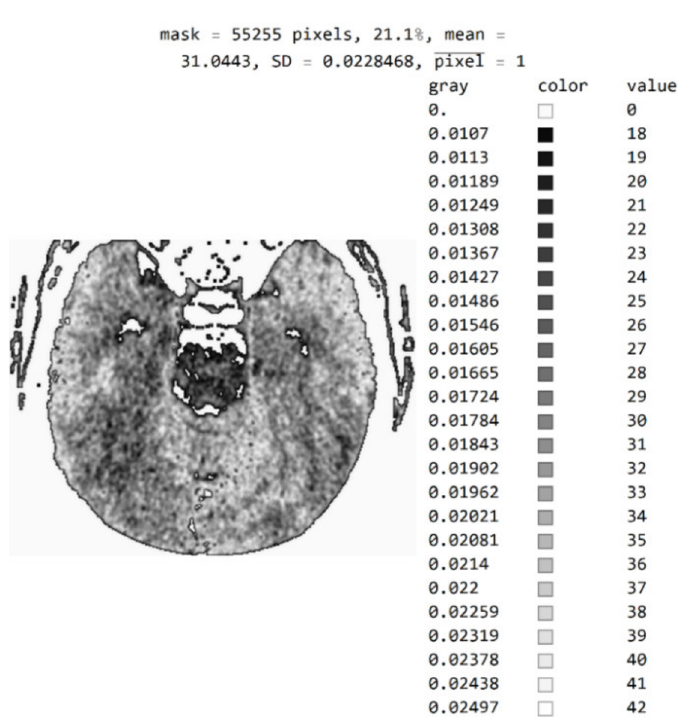
Figure A1. Image with exact integer values, the shades of gray scaled from black (pixel value 18) to white (pixel value 42), with all other pixels outside this range displayed as 0 and shown in white.